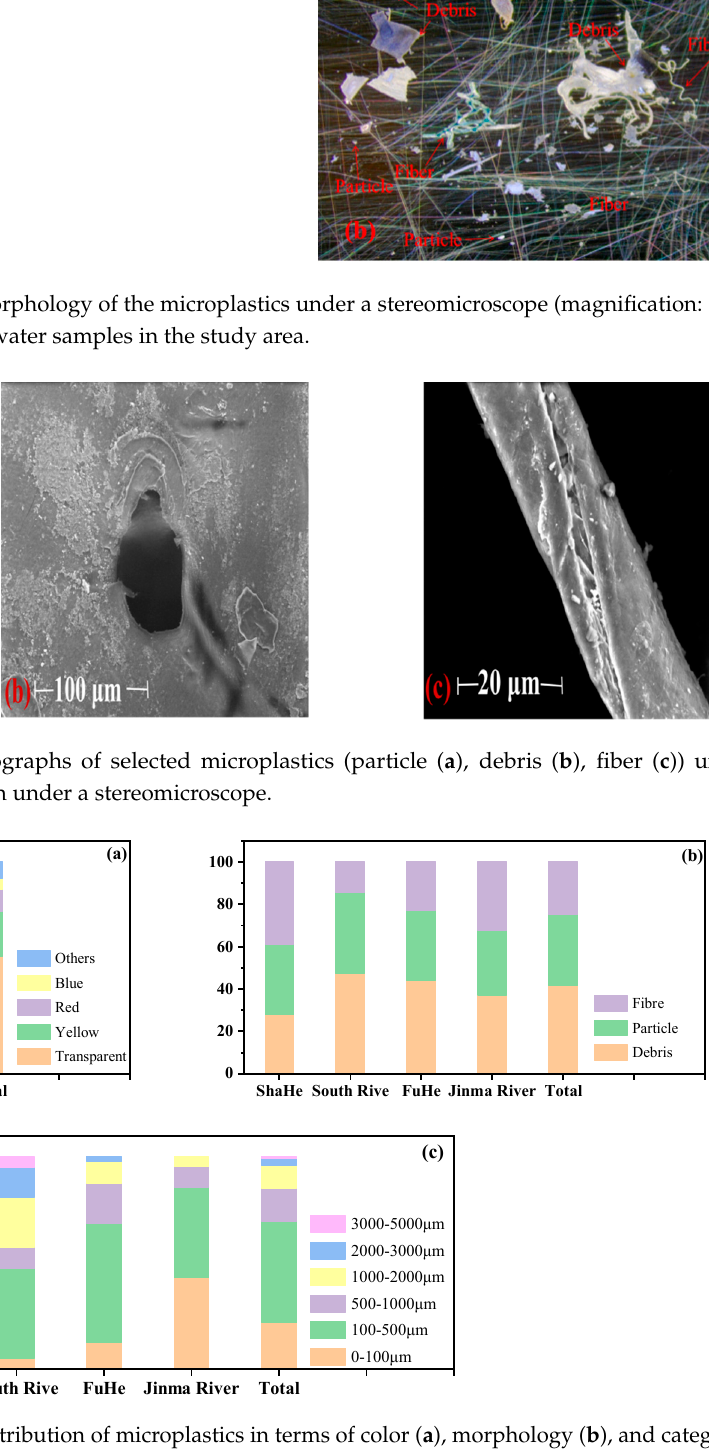
Figure 4. The distribution of microplastics in terms of color ( a ), morphology ( b ), and categories ( c ) in the rivers.